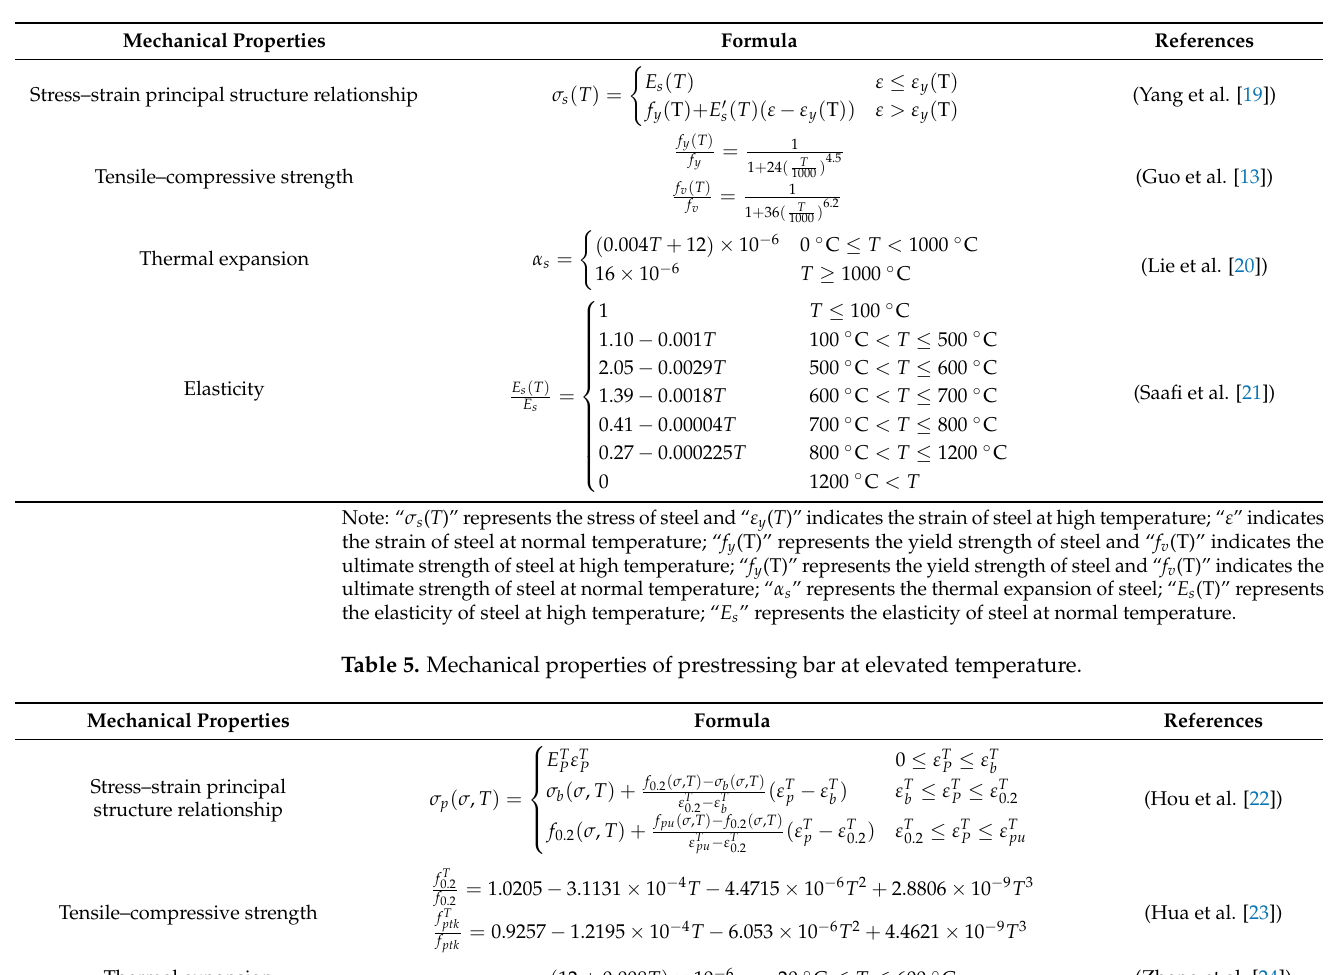
Table 4. Mechanical properties of steel at elevated temperature.